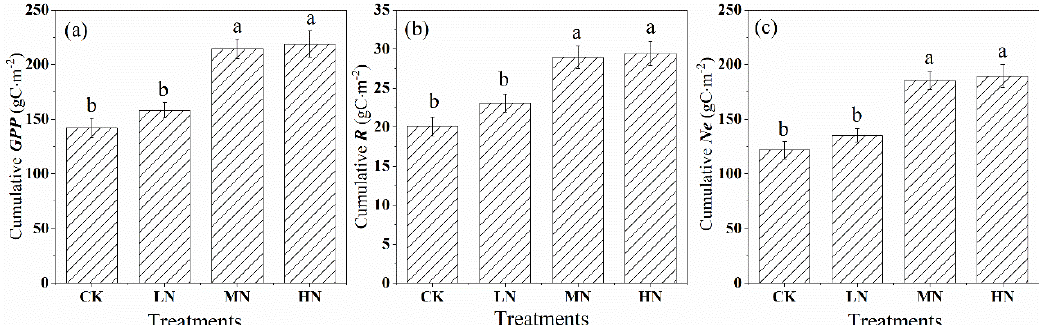
Figure 7. Cumulative values of gross primary productivity ( GPP ). ( a ) crown respiration ( R ), and ( b ) net crown carbon exchange ( Ne ), ( c ) after nitrogen addition and the control during the growing season (from June to September). CK, LN, MN and HN represent control (no nitrogen addition), low nitrogen addition (23 kgN · hm − 2 · a − 1 ), medium nitrogen addition (46 kgN · hm − 2 · a − 1 ) and high nitrogen addition (69 kgN · hm − 2 · a − 1 ), respectively. Letters (a, b, or c) suggest significant differences between treatments at α = 0.05.